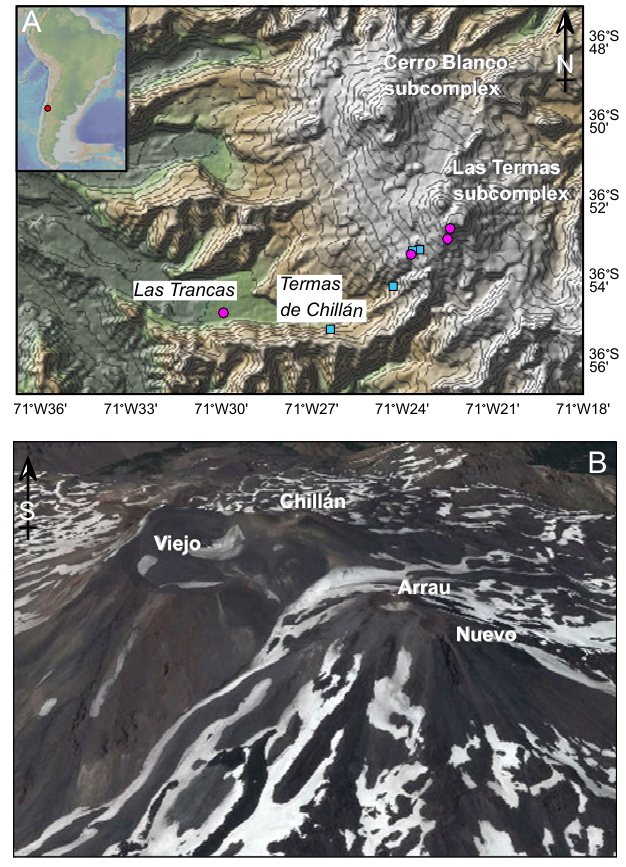
Figure 1: [A] DEM of the Nevados de Chillán Volcanic Complex. The Cerro Blanco and Las Termas subcom- plexes are visible together with the surrounding valleys in which lahar and pyroclastic flow hazards are concen- trated. The towns of Las Trancas and Termas de Chillán are shown. Contour lines are drawn every 100 meters and go from 3200 to 600 m. Purple circles show the location of tephra samples. Blue squares show the lo- cation of site used for remote sensing observations with UV cameras. [B] Google Earth view of the Las Termas subcomplex looking south at the Nuevo, Arrau, Viejo and Chill an cones (image: Centre National d’étude spatial, 3 January 2014, 4 km eye altitude). Map data: Google, DigitalGlobe ©2018, CNES/ Airbus